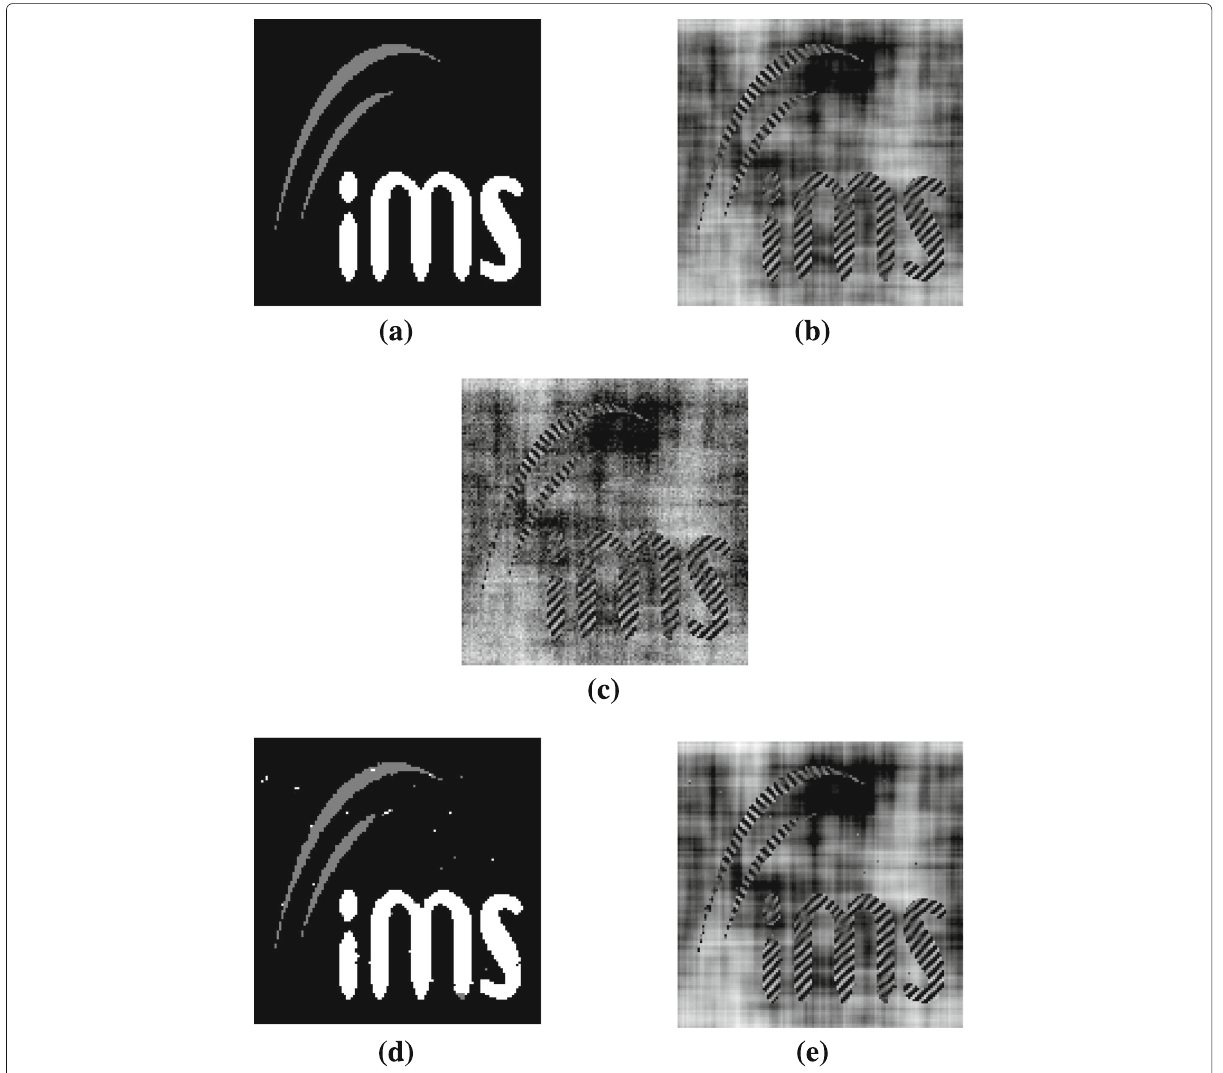
Fig. 7 Segmentation and reconstructed images (Example 3). a True labels (cid:2) ∗ . b True image z ∗ . c Data y . d Estimated labels ˆ (cid:2) . e Estimated image ˆ